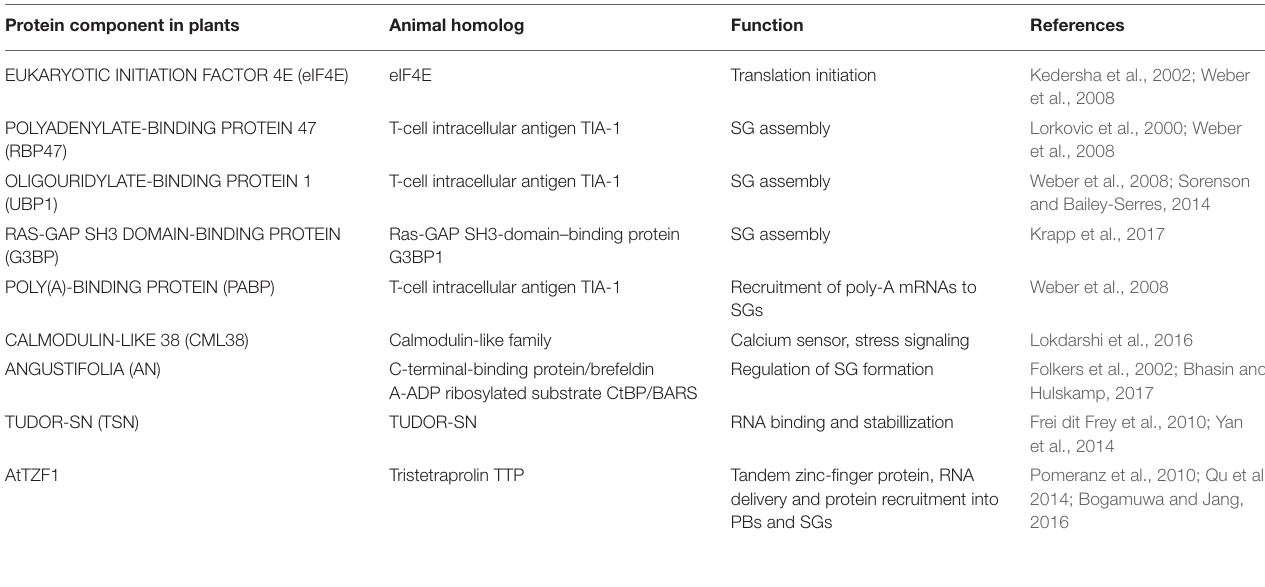
TABLE 1 | Plant stress granule proteins and their animal